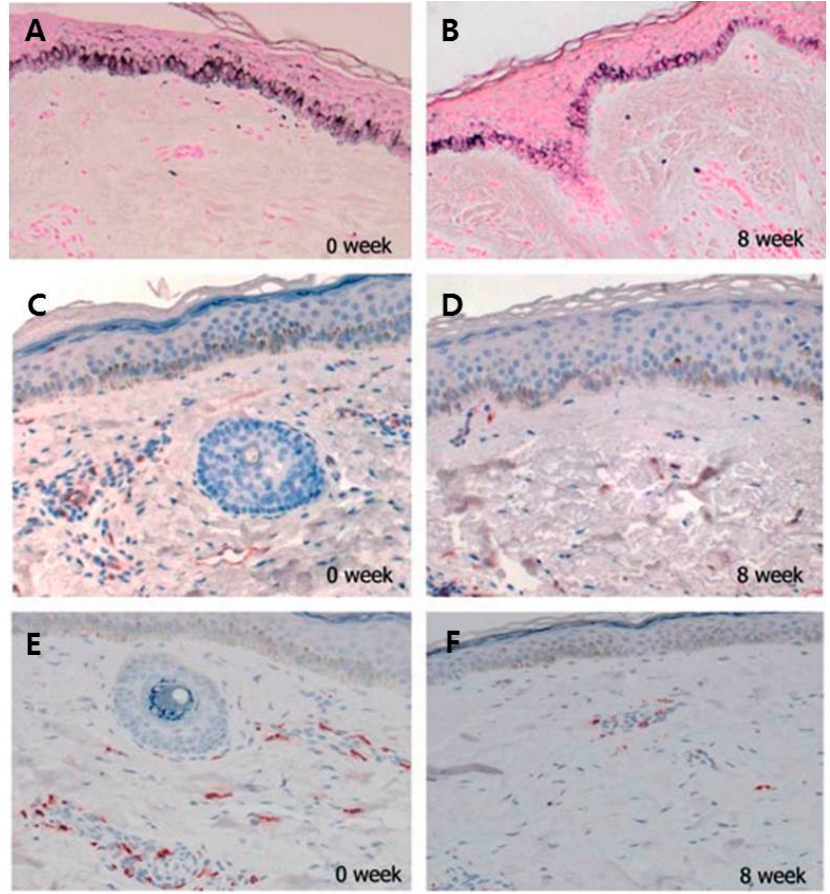
Figure 2. Histologic changes after eight weeks of treatment with tranexamic acid. ( A , B ) Fontana–Masson staining shows reduced epidermal pigmentation (×100); ( C , D ) Anti-CD31 staining shows reduced levels of vascularity (×100); and ( E , F ) Antitryptase staining shows reduced mast cell numbers (×100). Reproduced from [31].